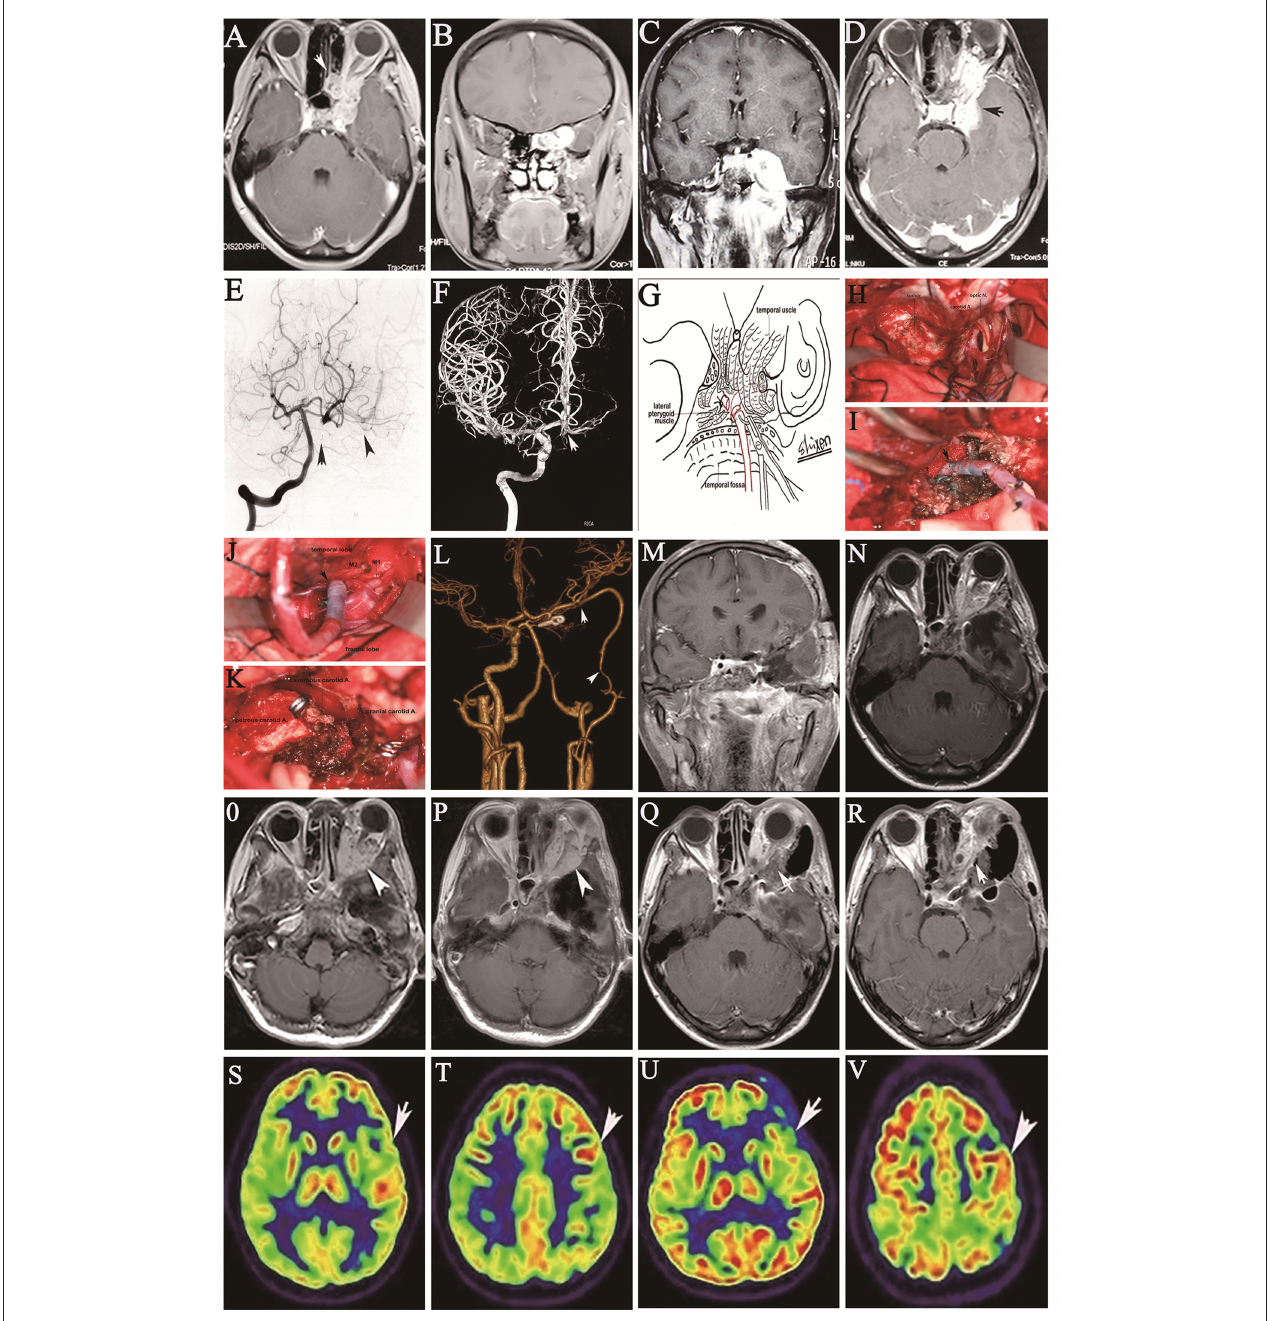
FIGURE 4 | Coronal (A) and axial (B) preoperative contrast-enhanced MRI shows a left orbital apex tumor extending to the ethmoid sinus before endoscopic transnasal surgery. Three months after endoscopic transnasal surgery, coronal (C) and axial (D) MRI with contrast shows regrowth of the tumor in the left cavernous sinus, orbital cavity and apex and middle cranial fossa. Angiography shows partial cross-filling of the right PComA to the right intracranial ICA after balloon occlusion of the cervical ICA on the left vertebral angiogram; the arrow indicates a balloon in the lumen of the cervical ICA, and the arrowheads indicate the right MCA (E) . Rare cross-filling of the right AComA to the left ACA after balloon occlusion of the cervical ICA is shown on left ICA angiography (F) . Drawing of the surgical procedure shows end-to-end anastomosis of the RA grafted to the IMA in the inferior temporal fossa through a frontotemporal craniotomy with resection of the zygomatic arch (G) . Intraoperative images show the tumor in the cavernous and petrous regions following opening of the Sylvian fissure through a frontotemporal craniotomy with resection of the zygomatic arch (H) , end-to-end anastomosis of the RA grafted to the IMA in the inferior fossa (I) , end-to-side anastomosis of the RA grafted to the proximal M2 segment of the MCA (J) , and the operative field after gross total resection of the tumor with encasement of the cavernous ICA; two clips of the distal and